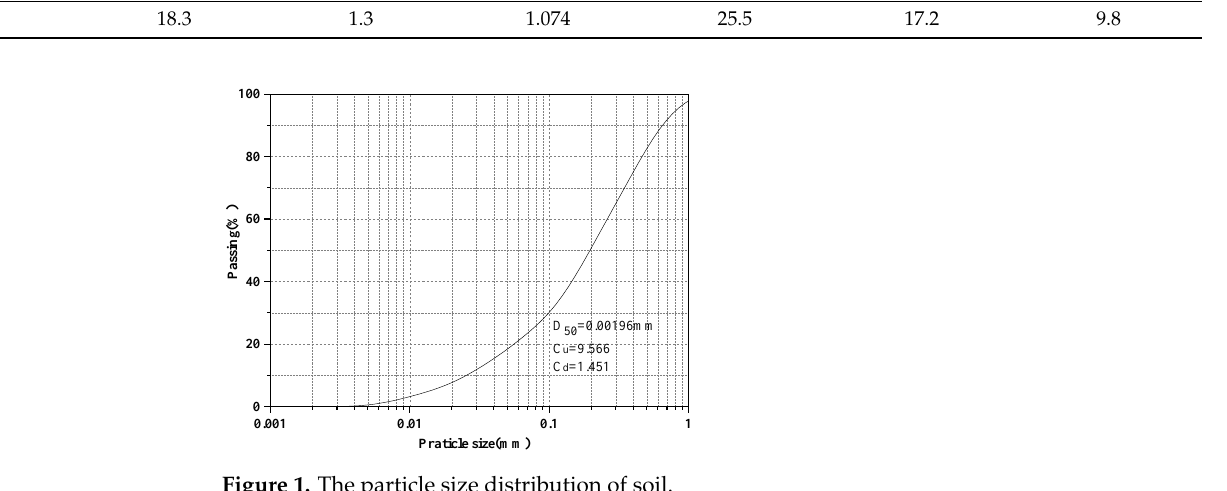
Table 1. Index properties of the tested soil.